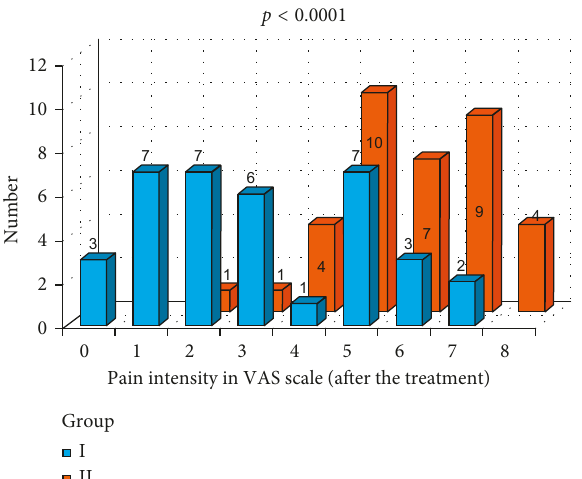
Figure 15: Pain intensity schedule in VAS scale after the prosthodontic treatment: group I and group II comparison.